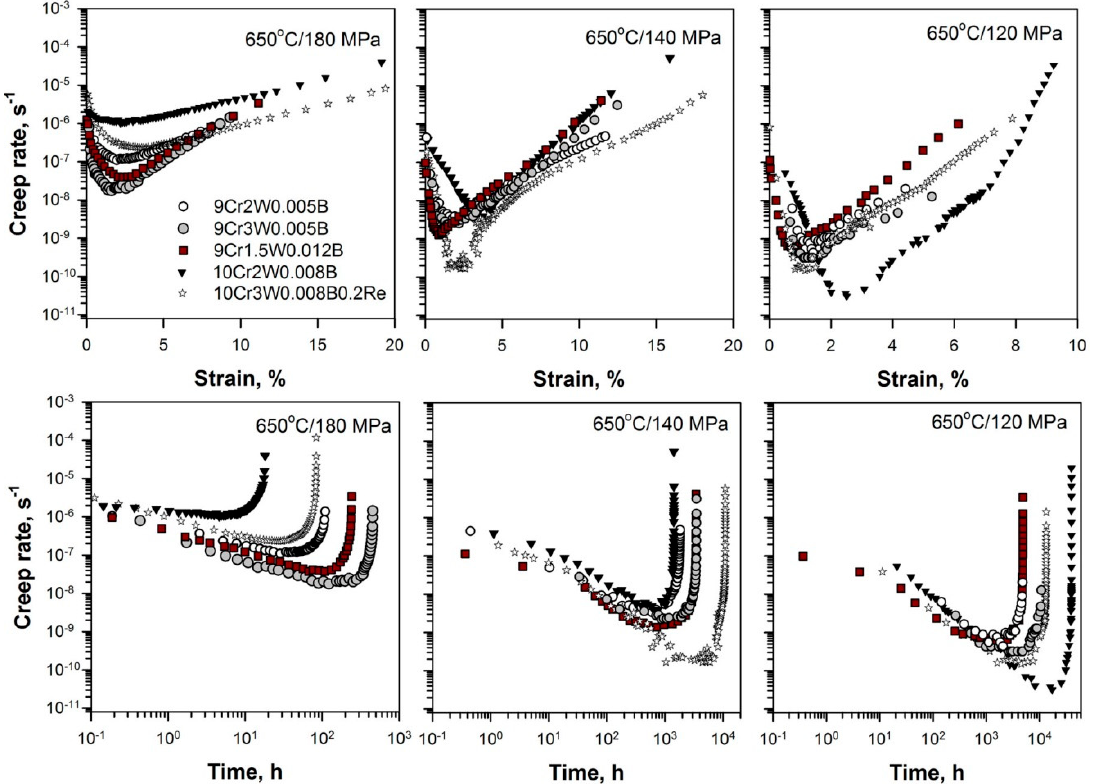
Figure 3. Creep rate vs. strain and creep rate vs. time curves of the steels studied at 650 ◦ C under the applied stresses of 180,